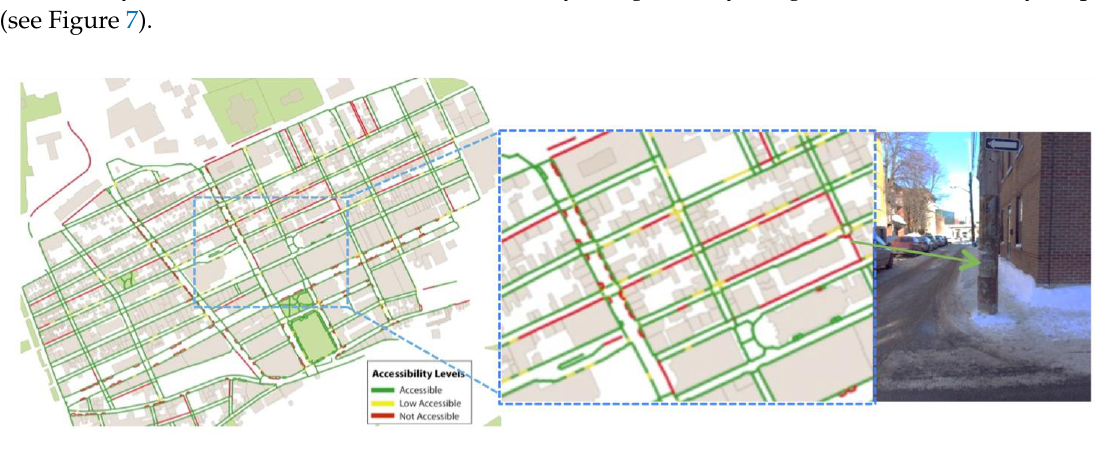
Figure 7. The accessibility of sidewalks in the study